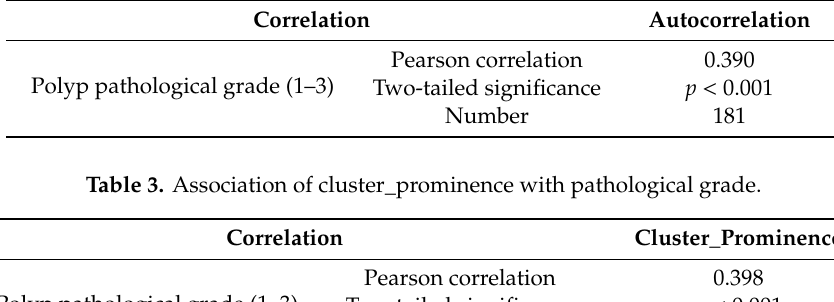
Table 2. Association of autocorrelation with pathological grade.